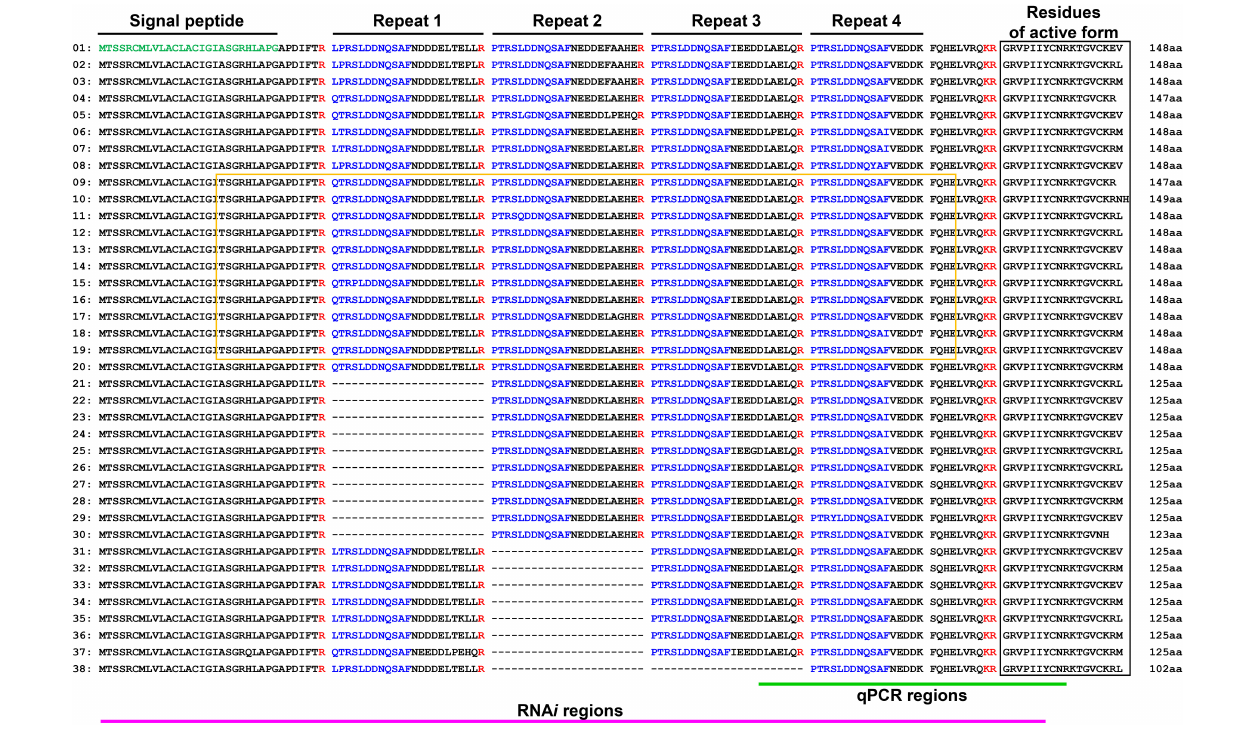
Frontiers in Microbiology |